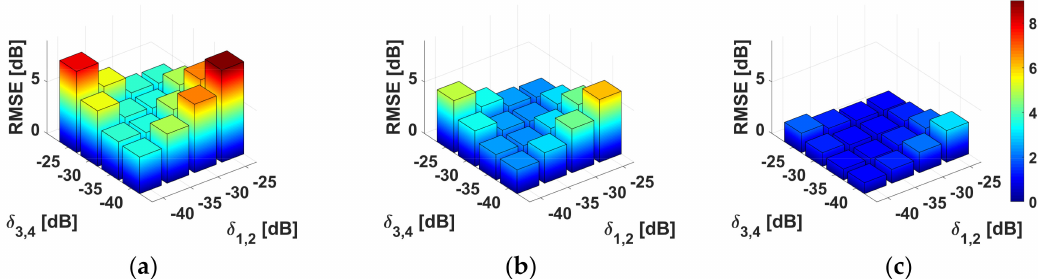
Figure 1. Root mean square error (RMSE) of cross-talk estimates for cross-talk amplitude variability, using simulation data obtained by ( a ) the Van Zyl method, ( b ) the Quegan method, and ( c ) the Villa